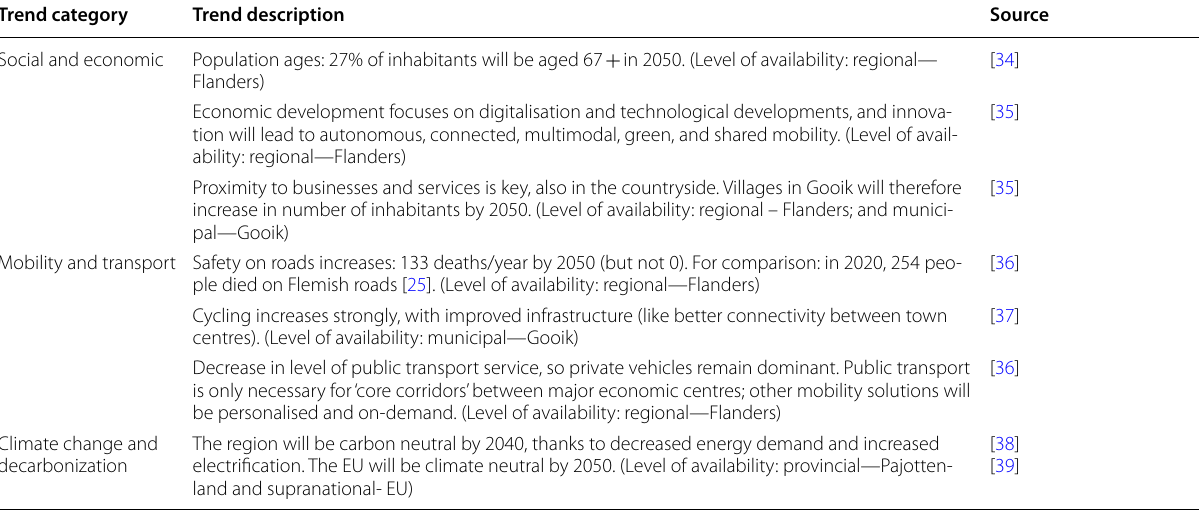
Table 1 Oetingen 2050 BAU projection